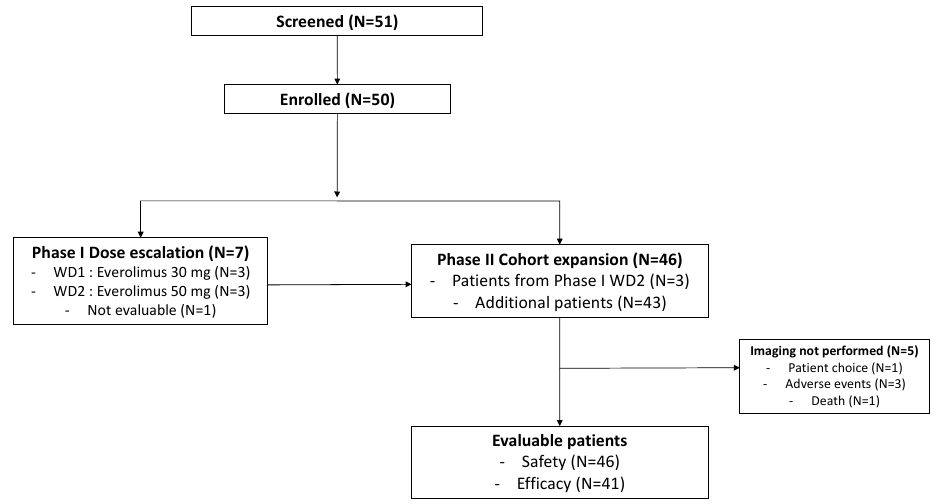
Figure 1. Flow chart (WD: weekly dose).